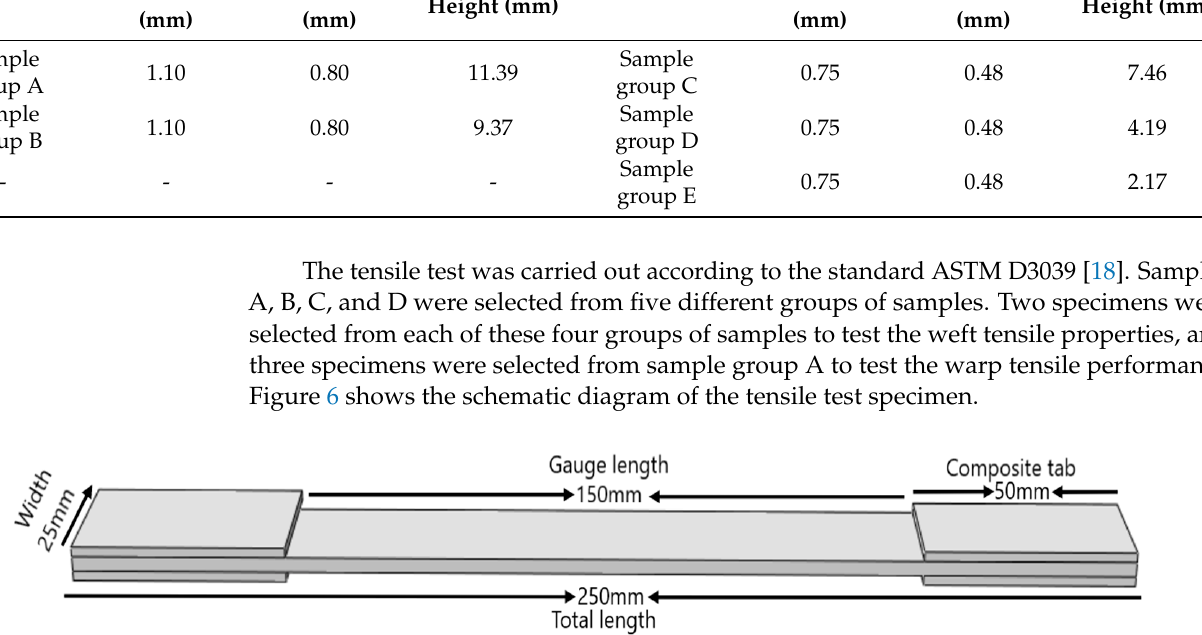
Table 3. Two sets of samples for comparison.